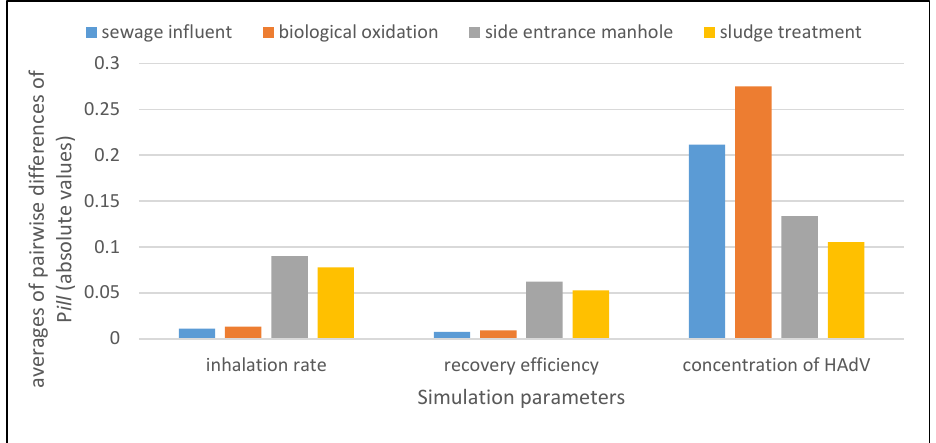
Figure 4. Sensitivity analysis determines how a change in each input parameter (inhalation rate r in , recovery efficiency r eff , and concentration of HAdV C HAdV ) affects the change of the probability of illness.